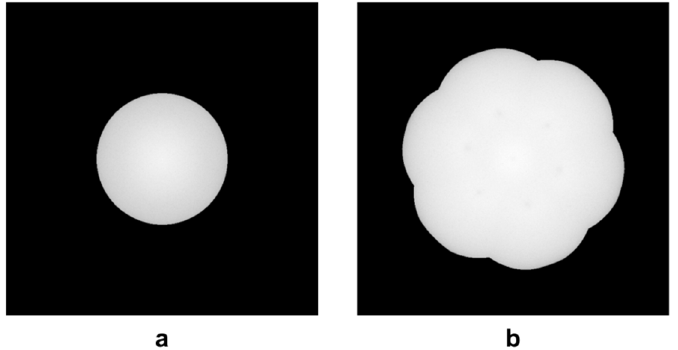
Figure 1. Comparison of optical transfer functions (OTFs): Wiener filtered wide-field ( a ) and structured illumination with two interfering laser beams at angles of 0°, 60° and 120° ( b ).